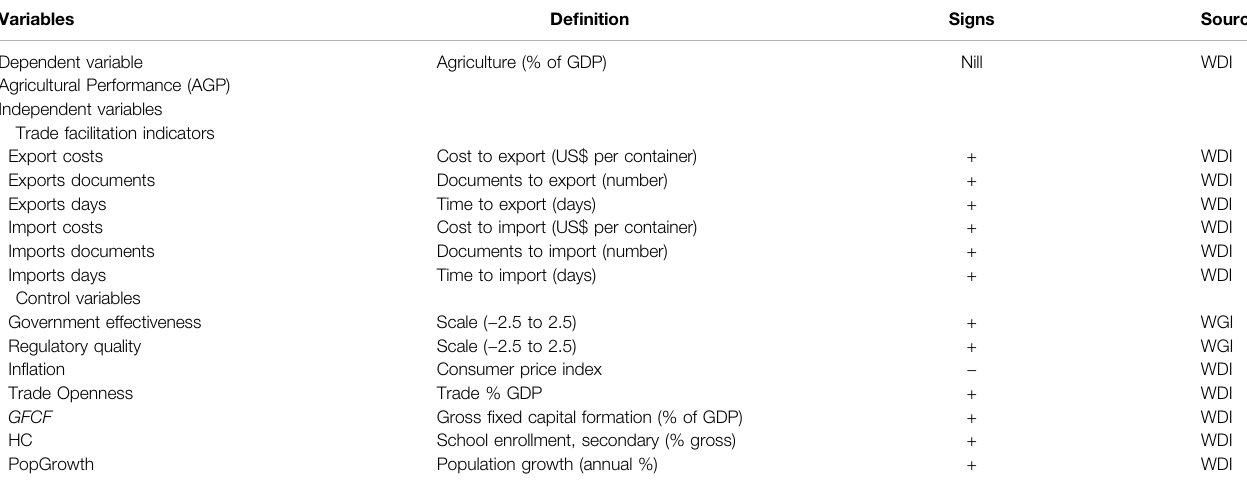
TABLE 3 | De fi nition of variables and data